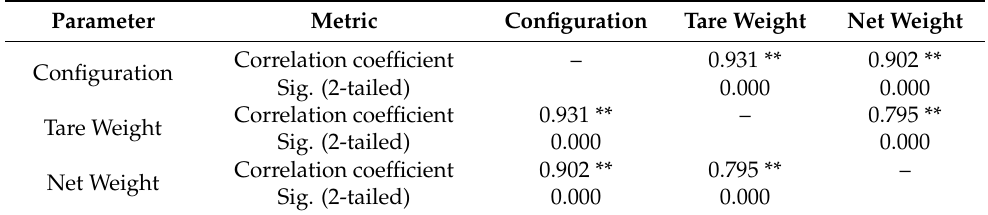
Table 8 . Spearman’s rho test results.